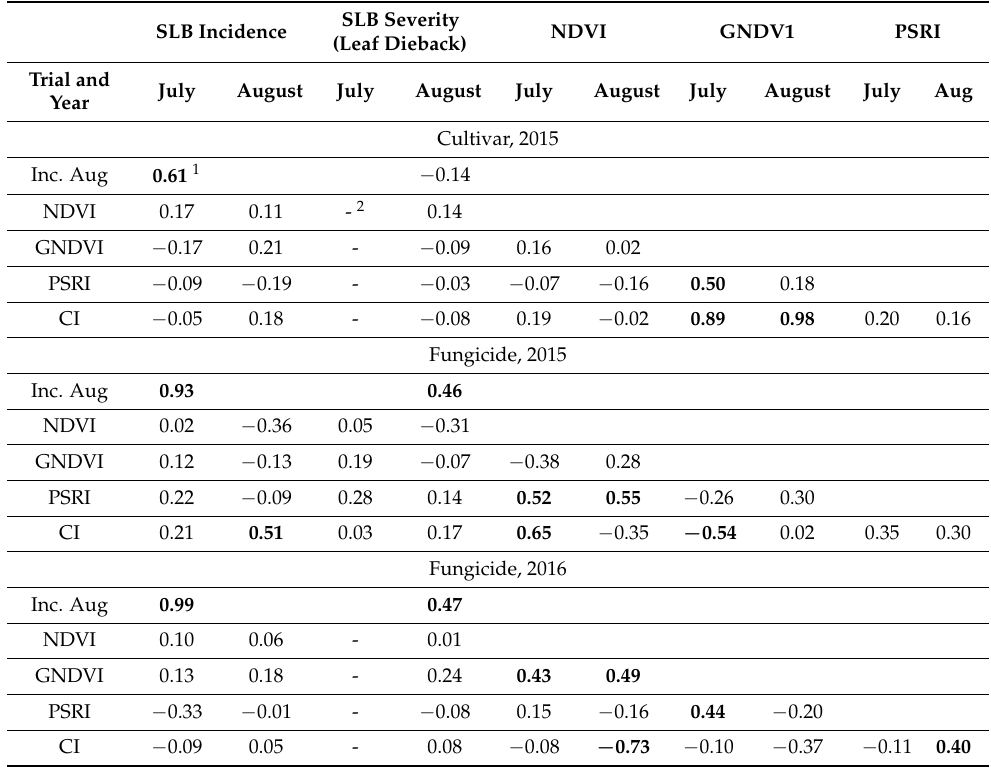
Table 5. Correlation matrix for Stemphylium leaf blight (SLB) incidence and severity in July and August in relation to four vegetative indices from onion trials conducted at the Muck Crops Research Station, Ontario in 2015 and